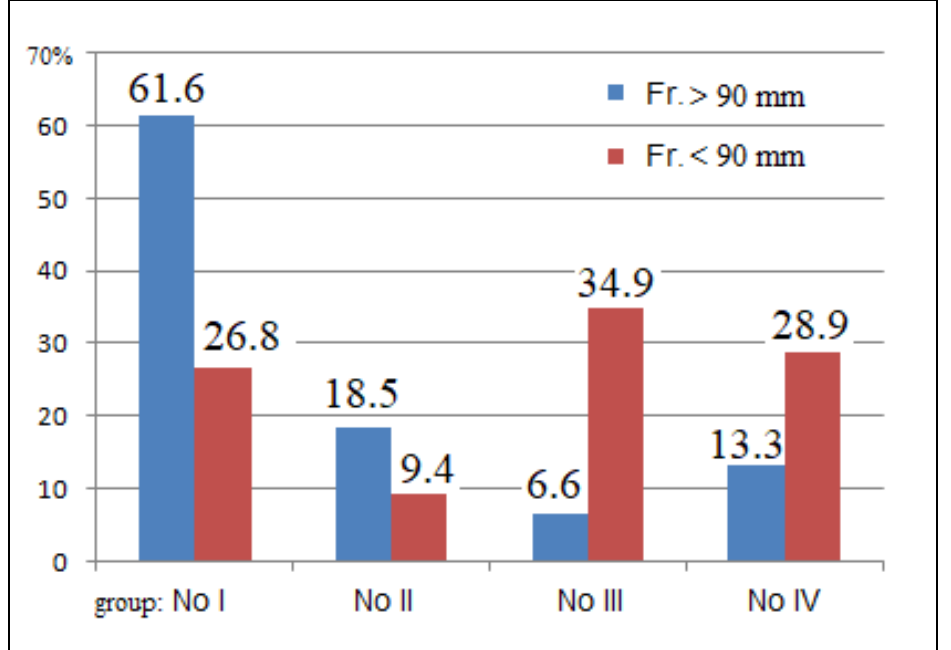
Figure 3. Percentage of four groups (I–IV) in two particle size fractions.